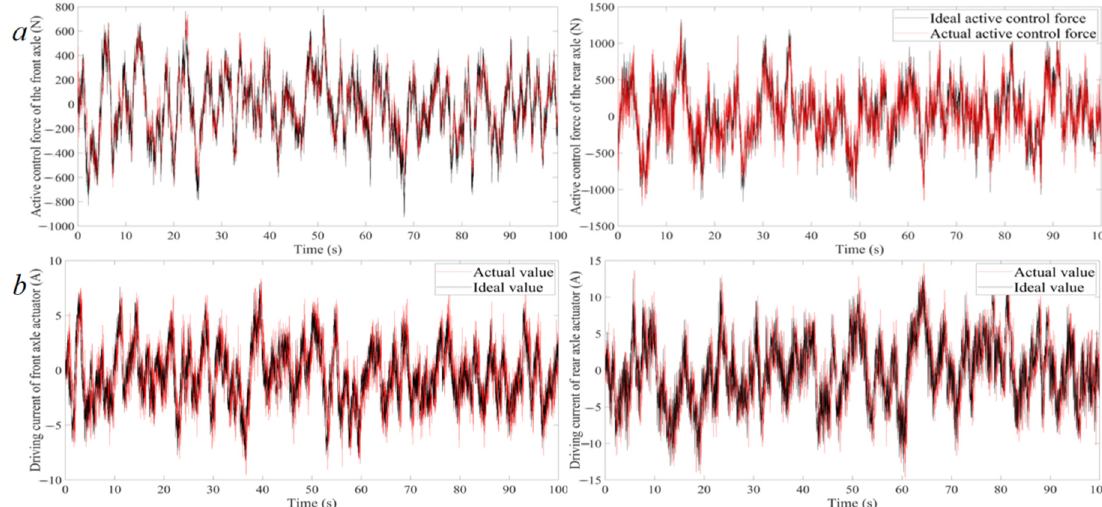
Figure 13. Comparison of test and simulation. ( a ) Active control force. ( b ) Drive current of active suspension actuators.